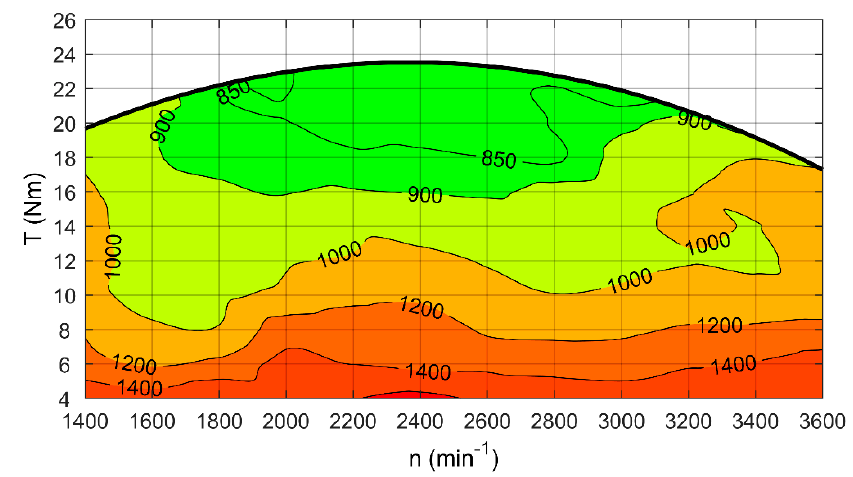
Figure 10. CO 2 emission (g/kWh) from the range extender supplied with LPG.